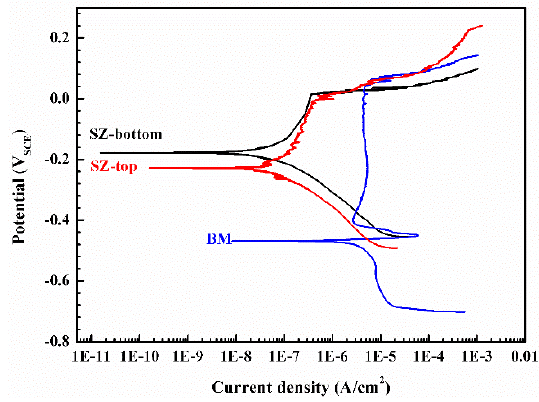
Figure 11. Potentiodynamic polarization curves of BM, SZ-top and SZ-bottom in 3.5 wt. % NaCl solution at 25 °C ± 0.5 °C. Metals 2016 , 6 , 301